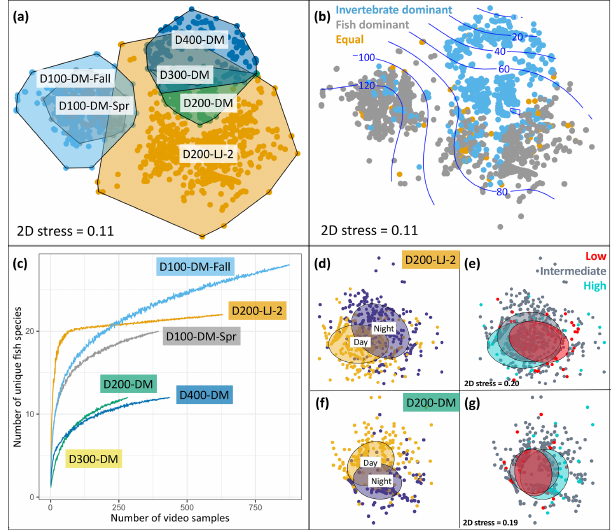
Figure 6. Seafloor community analyses using DOV BEEBE video samples. (a) Nonmetric multidimensional scaling (nMDS) plot showing seafloor community similarity across six deploy- ments. Points represent the Bray–Curtis similarity of square-root- transformed counts of animals observed in each 20s video sam- ple ( n = 3357) from each deployment ( n = 6). Points are color- coded by deployment, and a convex hull demarcates each deploy- ment community. (b) The same nMDS as in (a) , but points are color-coded by whether the seafloor community for each 20s video sample was dominated by invertebrates (blue), vertebrates (gray), or an equal proportion of vertebrates and invertebrates (gold). Blue contours indicate a relationship with oxygen concentration (µmolkg − 1 ). (c) Species accumulation curves showing differences in fish diversity across deployments. (d–g) Nonmetric multidimen- sional scaling plots showing differences in seafloor community composition as a function of day versus night (d–f) and oxygen conditions (e, g) for two deployments: D200-LJ-2 (d, e) and D200- DM (f, g) . In (d) and (f) yellow points represent daytime sam- ples (06:00–17:59) and purple points represent nighttime samples (18:00–05:59). In (e) and (g) , low-oxygen (red) and high-oxygen (blue) conditions represent the lowest and highest 10th percentile of oxygen conditions encountered during each deployment time series. Ellipses represent grouping by category and show 50% confidence limits. 2D stress is the same for (d) and (e) and for (f) and (g) . See Table 1 for camera deployment